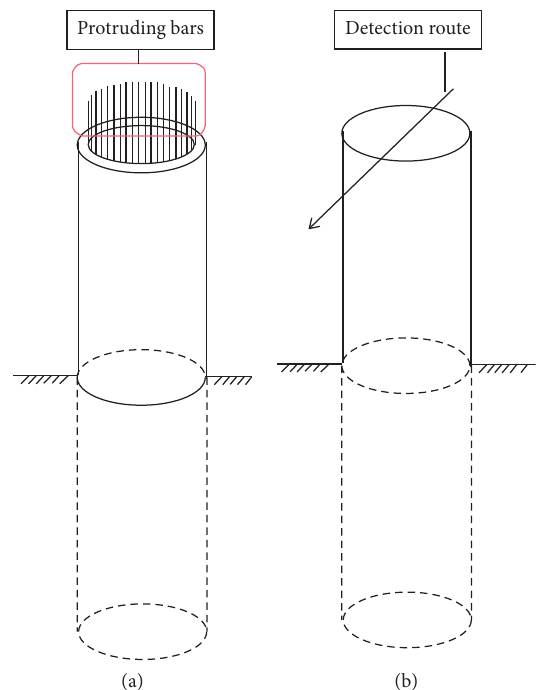
Figure 1: Pile foundation after construction. (a) Normal case with protruding bars and (b) the test pile